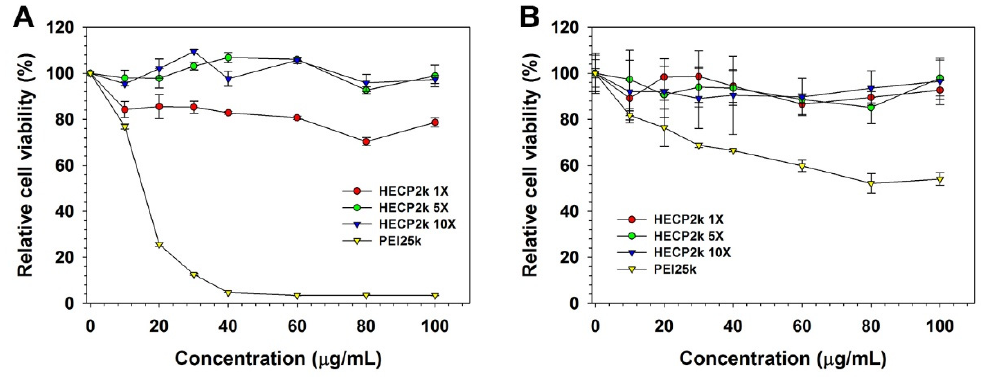
Figure 3. MTT assay results in ( A ) HeLa and ( B ) HepG2 cells.